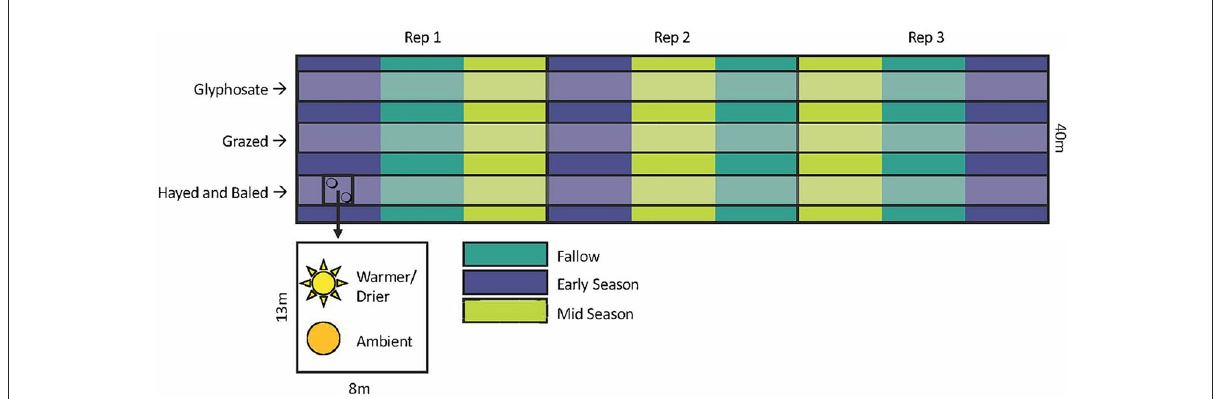
FIGURE1 Experimental design showing 1 year of the winter wheat—cover crop rotation. Open-top chambers with rain-out shelters were located at each combination of the cover crop or fallow strip plots and termination treatments (9 per replication). Within a 13 × 8m section of each crop and termination treatment, samples were taken from the 0.56 m 2 frames placed within the open-top chamber, and from an equivalently sized marked area representing ambient conditions which was ∼ 1m away from the structure.